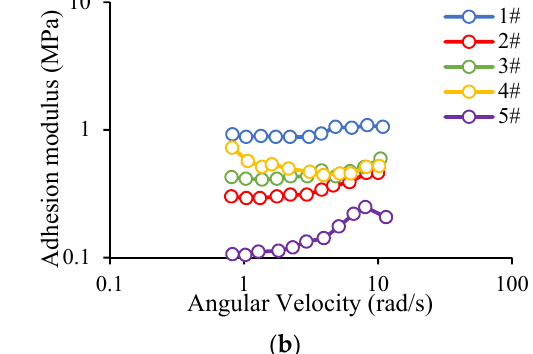
Figure 1. Viscosity versus time curve.